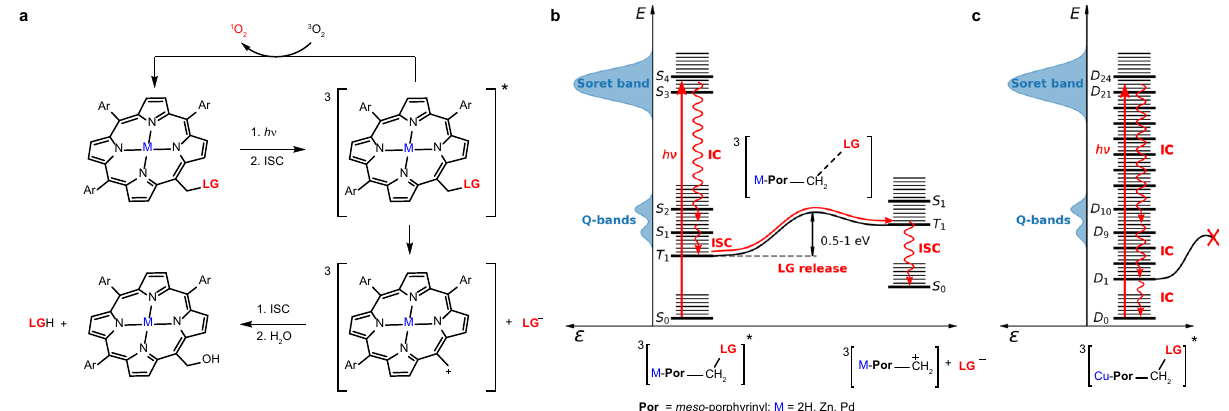
Fig. 6 Photochemistry of DMAP-caged porphyrin derivatives. a The proposed photorelease mechanism for porphyrin PPGs. b An extended Jablonski diagram for free-base, Zn, and Pd porphyrin PPGs. Intensities of the UV/visible transitions are also depicted. c An extended Jablonski diagram for a Cu porphyrin